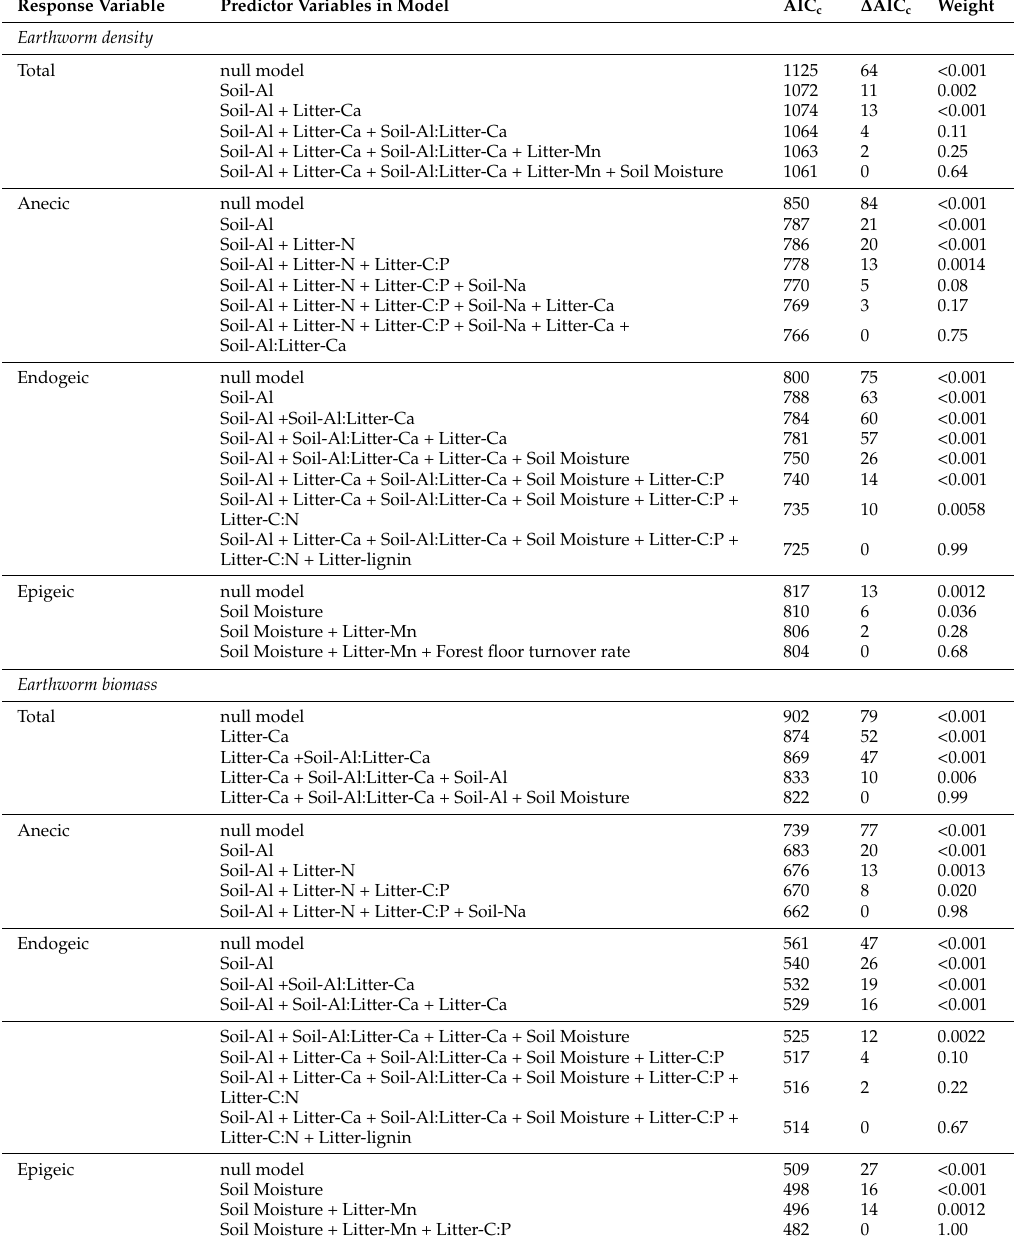
Table A2. Details of the results identifying optimal models for total, anecic, endogeic and epigeic density and biomass. We used glmmADMB zero inflated models with Site as random effect. Soil predictor variables were measured in the topsoil (0–5 cm). Soil-Al:Litter-Ca is the interaction between exchangeable soil Al concentration and litter Ca concentration. The foliar litter nutrient concentrations were previously published by Vesterdal et al.